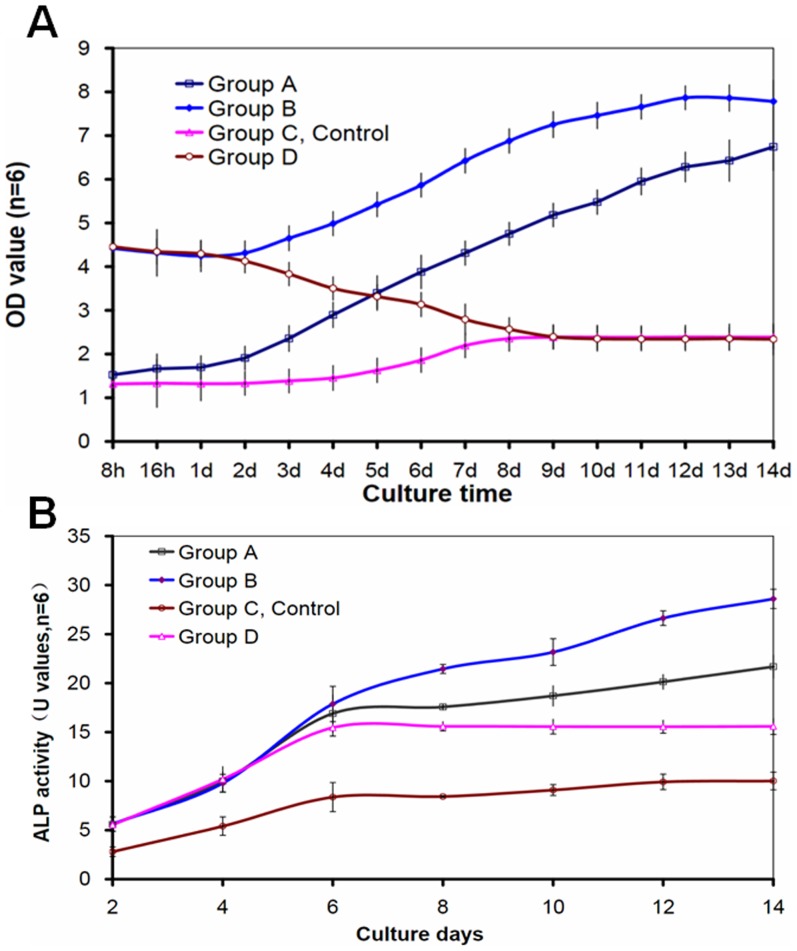
Proliferation of seeded cells in cell-scaffold constructs was detected by cell counting kit-8 (A) and osteoblastic differentiation of seeded cells in cell-scaffold constructs was evaluated by ALP activities (B).The number of cells was increased with culture time except group C. The dynamic culture (groups A and B) showed an obvious ability of promoting proliferation of cells. The ALP activities in all groups increased from day 2 to day 14 (B). The ALP activities in groups A, B, D were statistically higher than that in groups C(p<0.05) from day 4 to day 14. indicates a statistically higher value compared with group C(p<0.05).